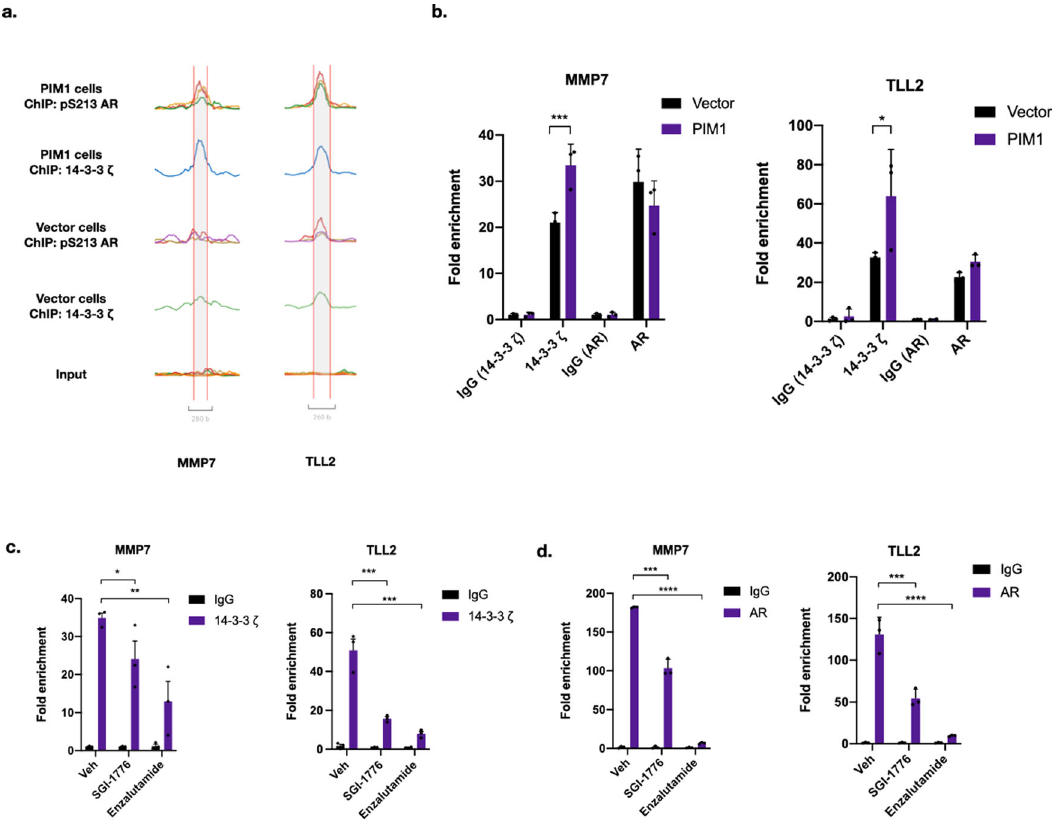
Fig. 6 AR and 14-3-3 ζ co-occupy chromatin at MMP7 and TLL2 in a PIM1-dependent manner. a ChIP-seq traces for 14-3-3 ζ and pS213 AR at MMP7 and TLL2 in control and PIM1 over-expressing LNCaP cells. b Validation of 14-3-3 ζ and AR binding at MMP7 and TLL2 by ChIP-PCR. 14-3-3 ζ shows increased binding in PIM1 over-expressing cells (MMP7: 33.47 + / − 2.64 vs. 21.07 + / − 1.22, p = 0.0029, TLL2: 63.95 + / − 13.81 vs. 32.62 + / − 1.43, p = .0248,